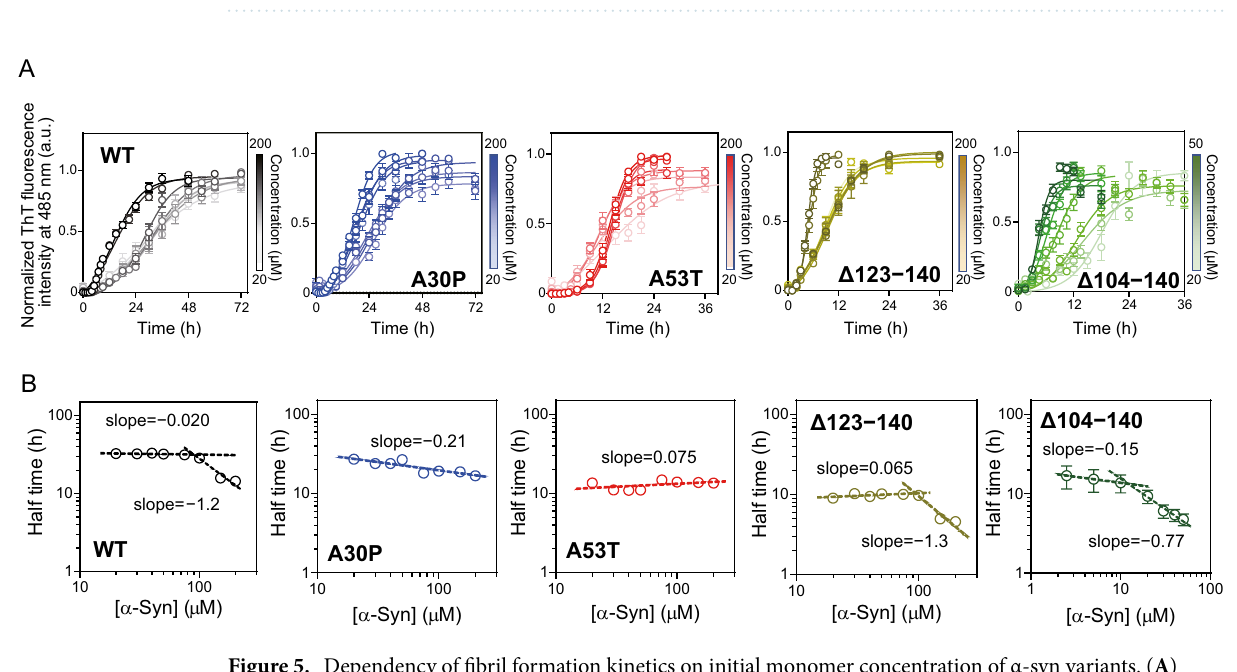
Figure 5. Dependency of fibril formation kinetics on initial monomer concentration of α-syn variants. ( A ) Normalized ThT fluorescence curves for fibrilization of α-syn at varying initial monomer concentration. Each experiment was repeated at least triplicated. Error bars represent S.E. The solid lines are the fitted curves by the Finke–Watzky 2-step model. ( B ) Double logarithmic plots of the half time for fibril formation and initial monomer concentration. Half time was determined according to the sigmoidal Eq. (1). The dashed lines are the linear regression lines. Values of the slopes were also shown. Error bars represent